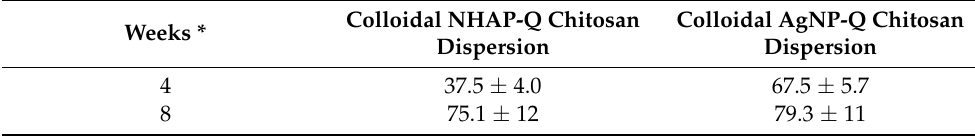
Table 2. Mean bone formation ( n = 5) expressed as % ±